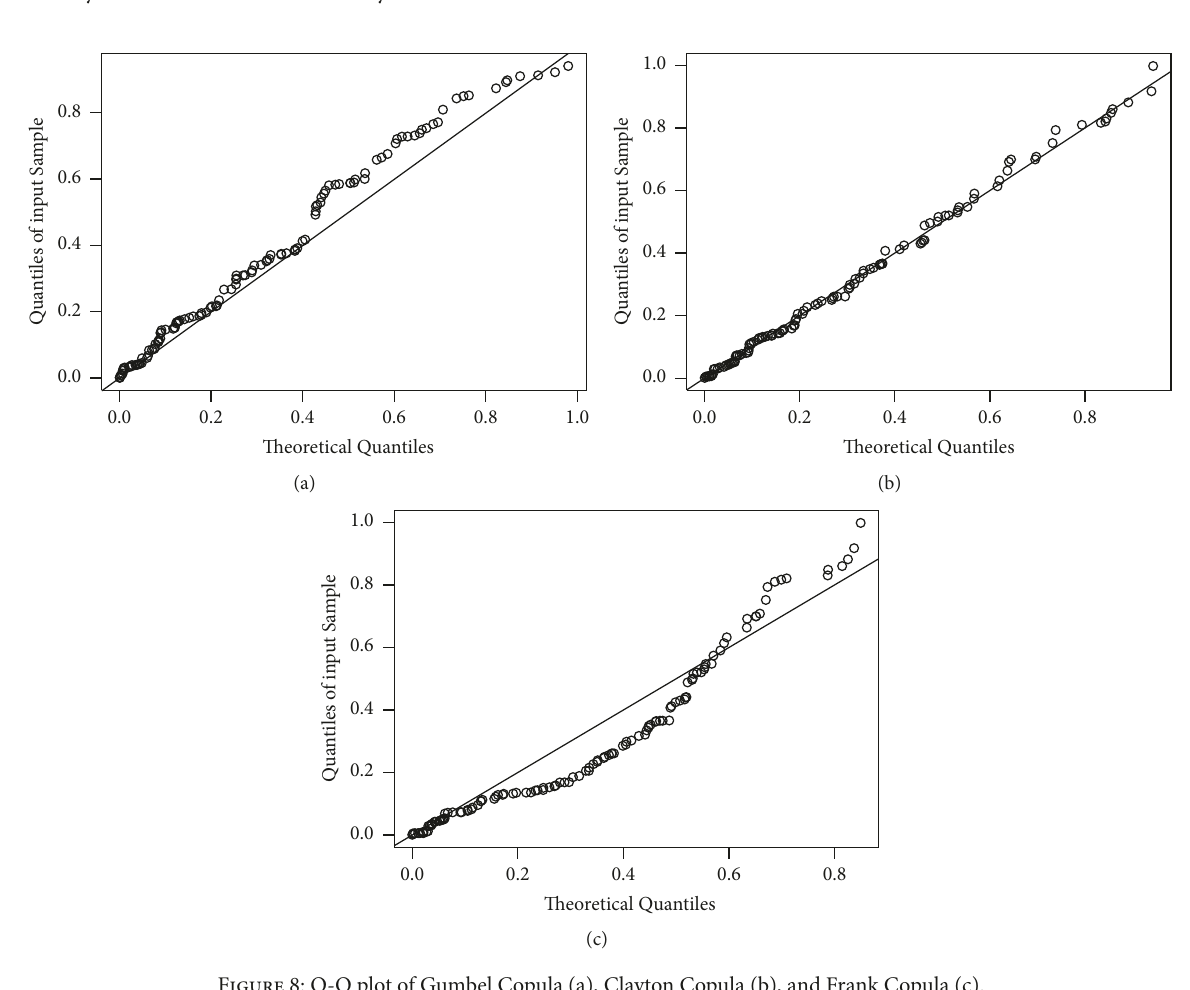
Figure 8: Q-Q plot of Gumbel Copula (a), Clayton Copula (b), and Frank Copula (c). Table 4: The sensitivity of intensity to cat bond when 𝑇 = 3